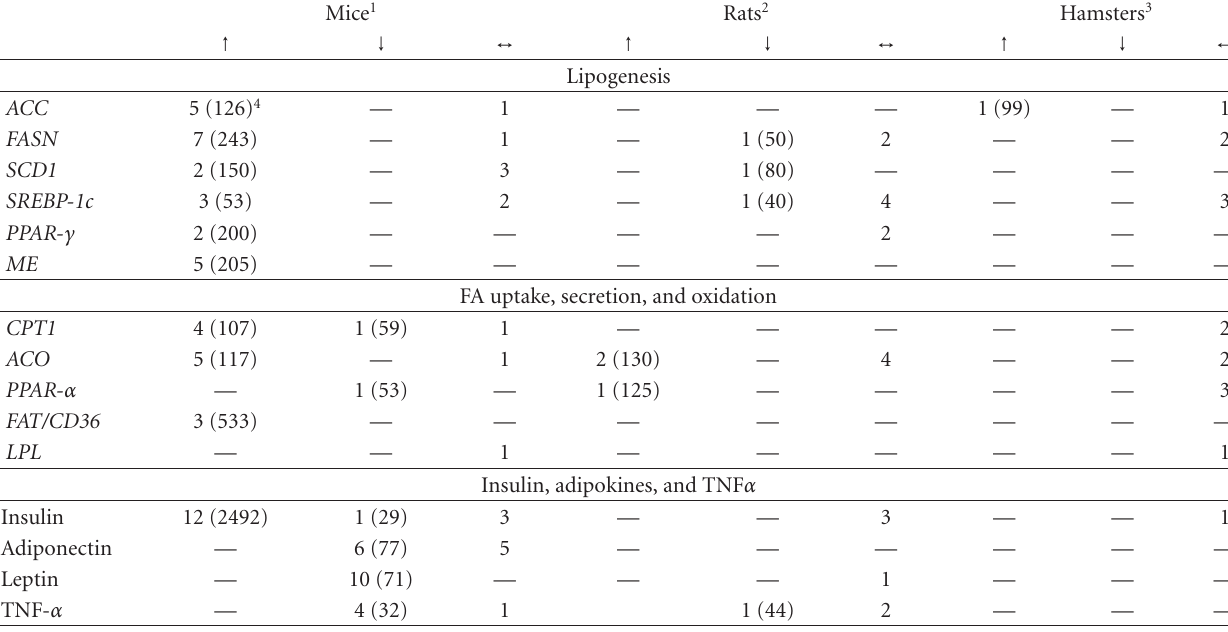
Table 2: Studies showing that trans -10, cis -12 CLA induced significant ( P < 0.05) increases ( ↑ ), decreases ( ↓ ), or no change ( ↔ ) ( P > 0.05) in hepatic gene expression and circulating levels of insulin, adipokines, and TNF- α . Genes are classified based on their ascribed function. Mice 1 Rats 2 Hamsters